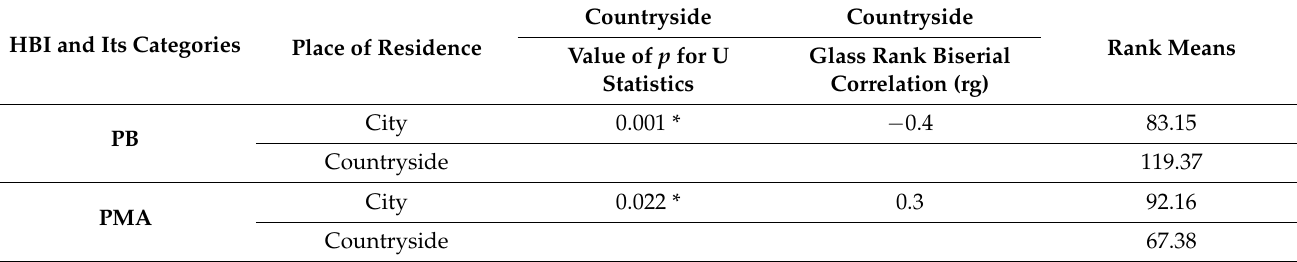
Table 9. Health behaviors of people practicing wheelchair basketball, wheelchair rugby and para- rowing depending on place of residence (the U test,